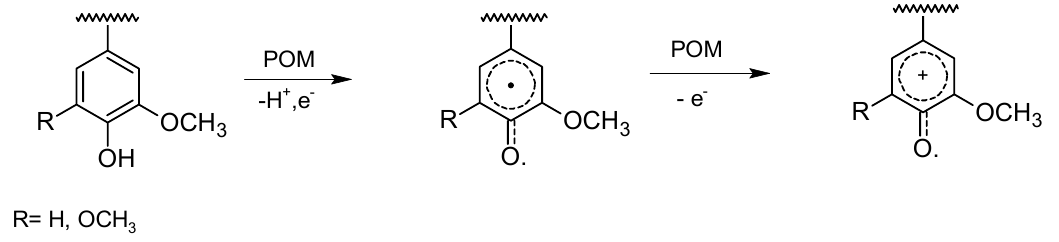
Figure 5. Proposed pathway for formation of the cyclohexadienyl cation upon oxidation of a phenolic lignin model compound by two equivalents of POMs